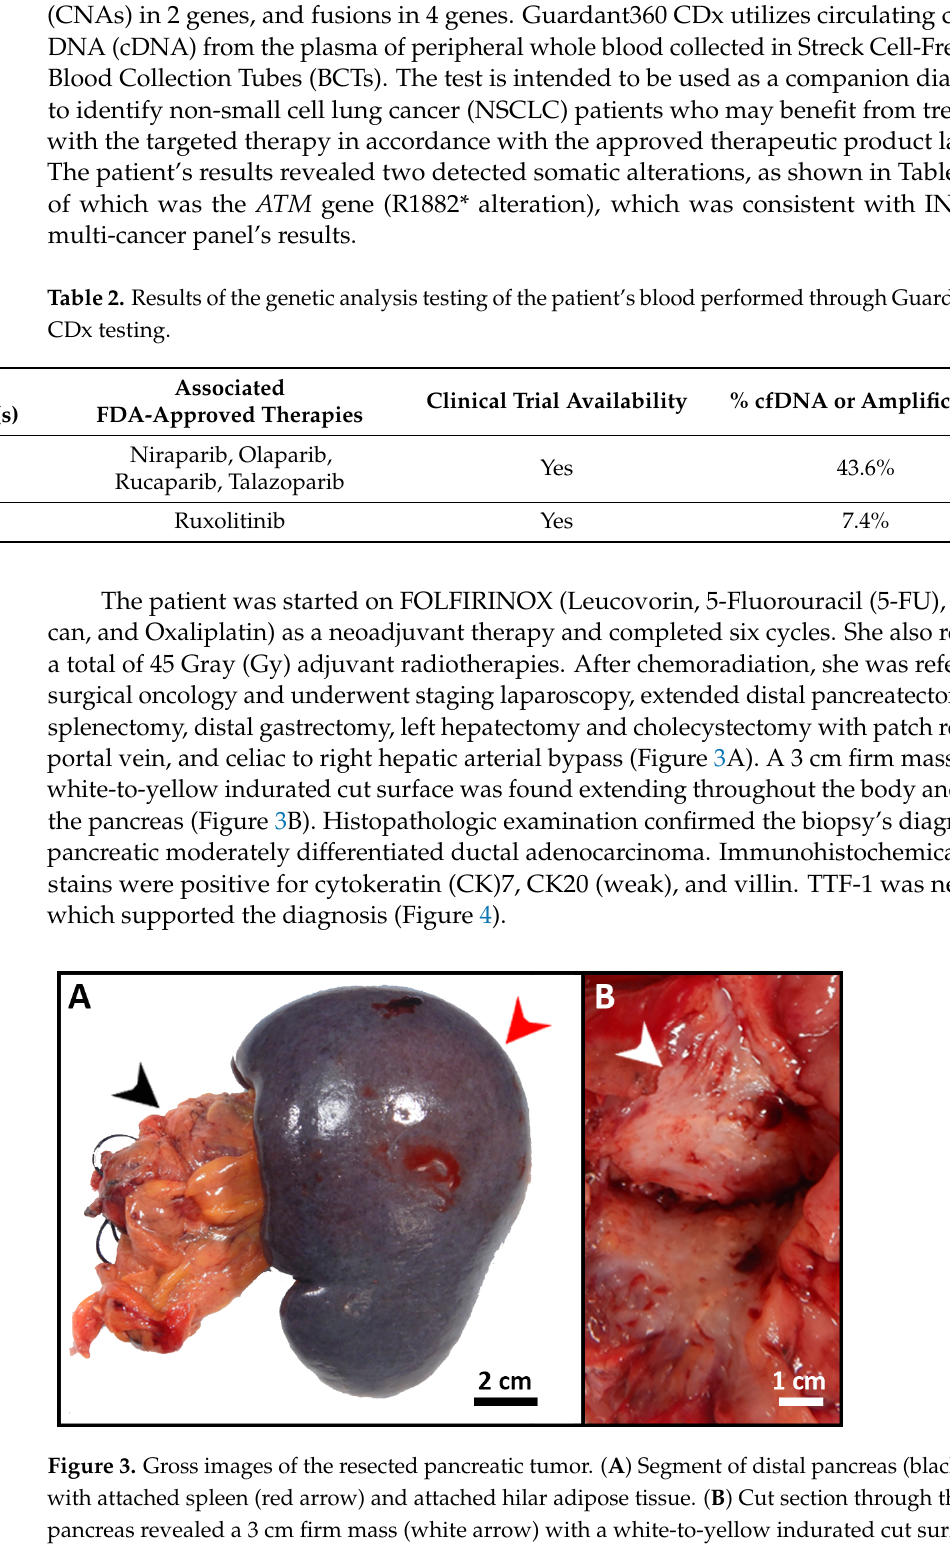
Figure 4. Microscopic images and immunohistochemical (IHC) stains of the pancreatic moderately differentiated ductal adenocarcinoma. Tumor cells were positive for cytokeratin (CK)7, CK20 (weak), and villin. TTF1 was negative. Microscopic images were examined at 200× objective. The patient’s postoperative course was complicated by duodenal stump leak and sepsis, for which the patient had a washout. The patient had a worsening liver ischemia, due to hepatic artery thrombosis and pneumonia, with subsequent respiratory failure that required intubation. She ultimately expired 11 days after the surgery.